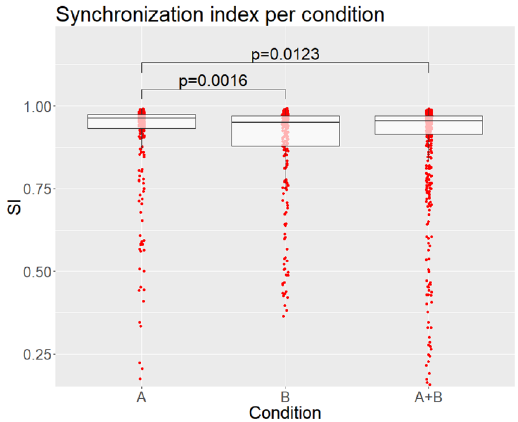
Figure 4. Synchronization per condition in the bidirectional scenario. Individual data points are shown as red dots, and the boxes represent the first and third quartiles, with the median shown as a dark line. P-values are obtained from Bonferroni corrected post-hoc